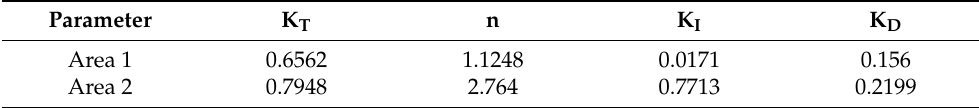
Table 11. TID controller parameters with a 0.4 s